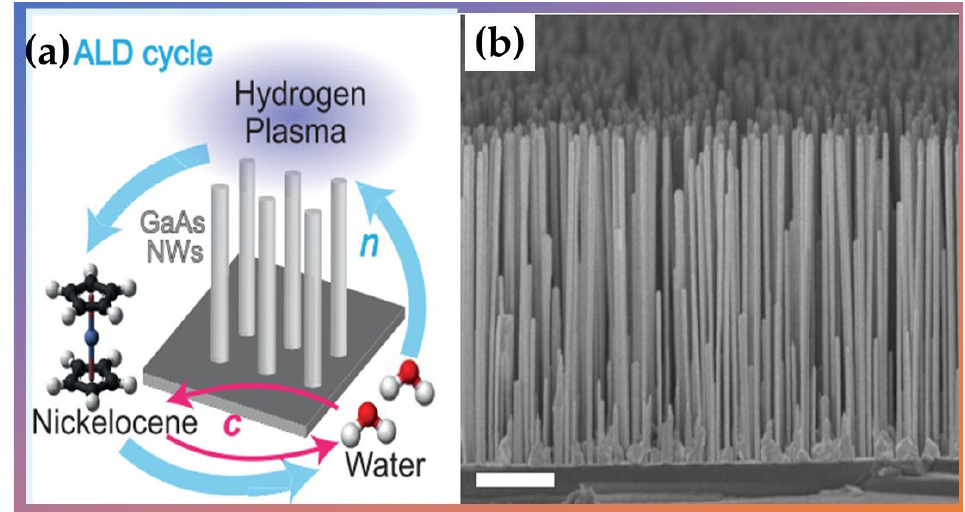
Figure 11. (a) Schematic ALD cycle used to synthesize nickel (Ni) nanotubes and (b) the scanning electron microscopy (SEM) micrographs of an ensemble of vertical nanowires with PA-ALD-grown Ni shells. Adapted from Ref. [103] with permission by Creative Commons 4.0.